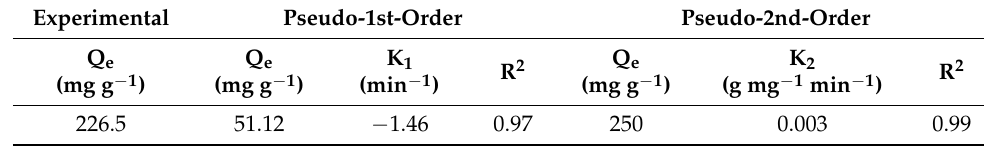
Table 1. Kinetic parameter values for the MG adsorption on AC@PIN composite.